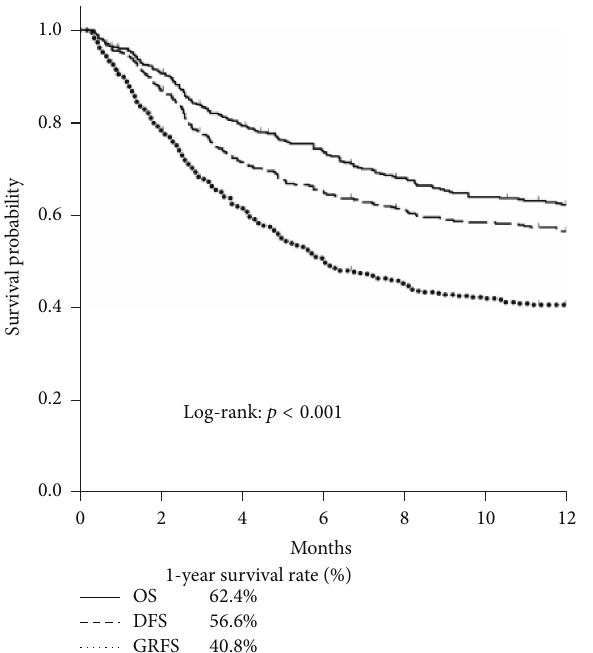
Figure 1: Kaplan-Meier estimates of 1-year GRFS.